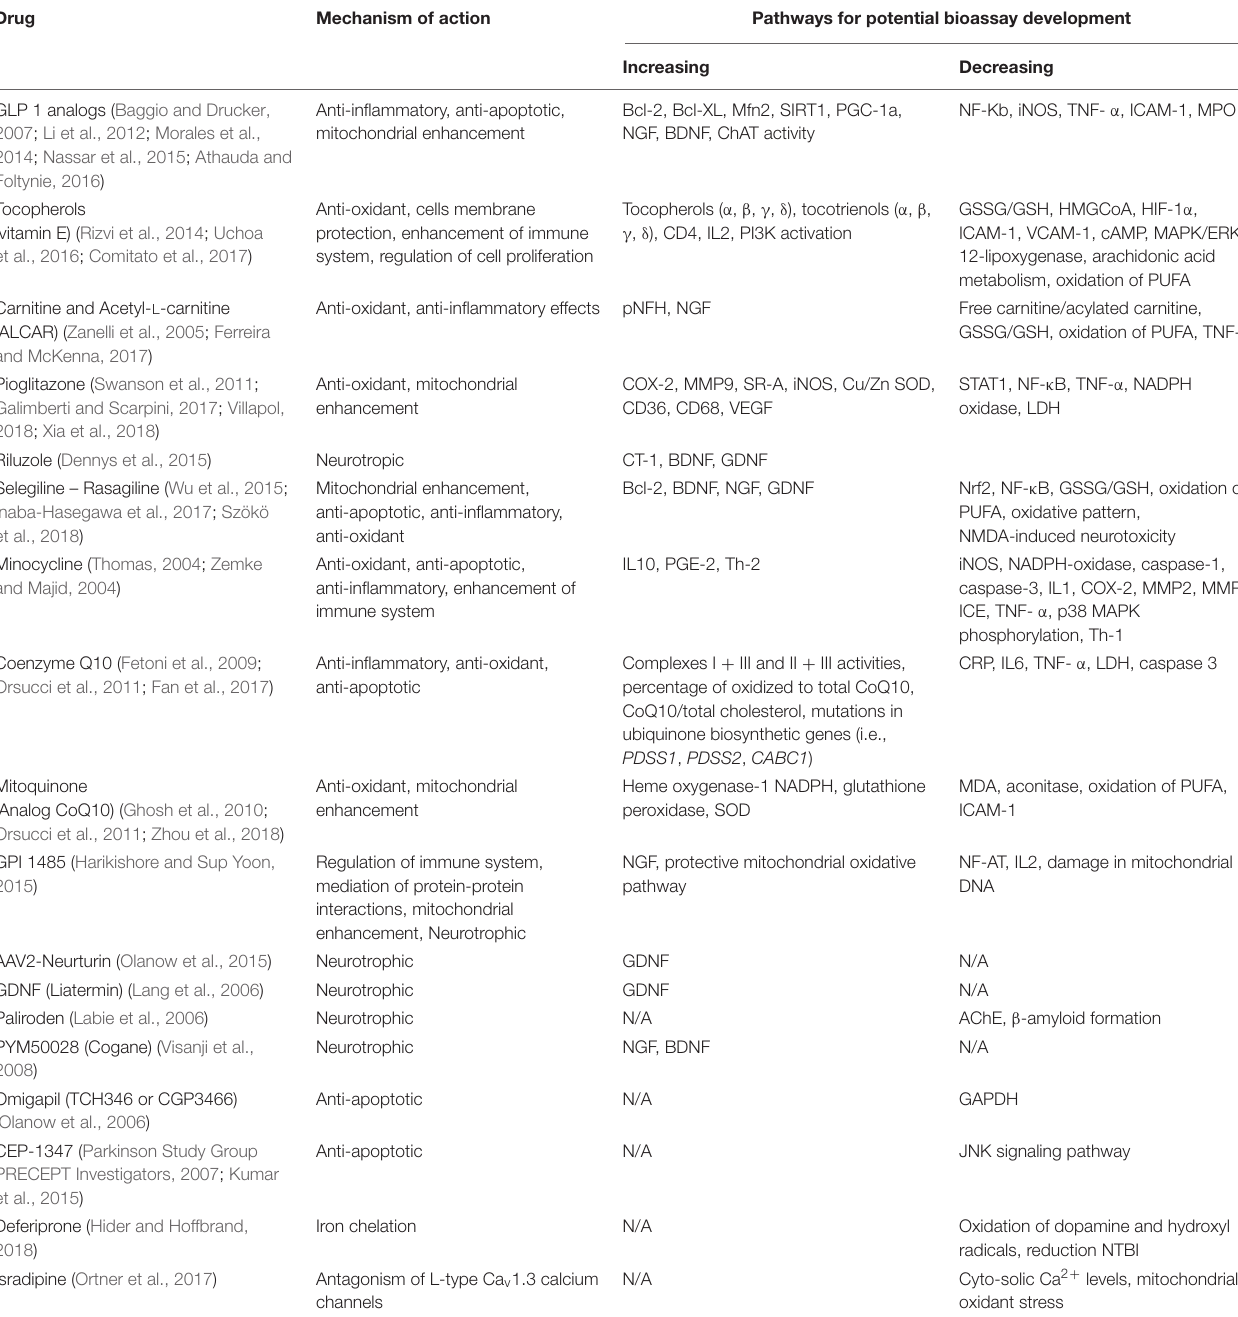
TABLE 2 | Available putative disease-modifying drugs for bioassay development (and targeted repurposing) examined in phase III clinical trials in Parkinson’s disease.